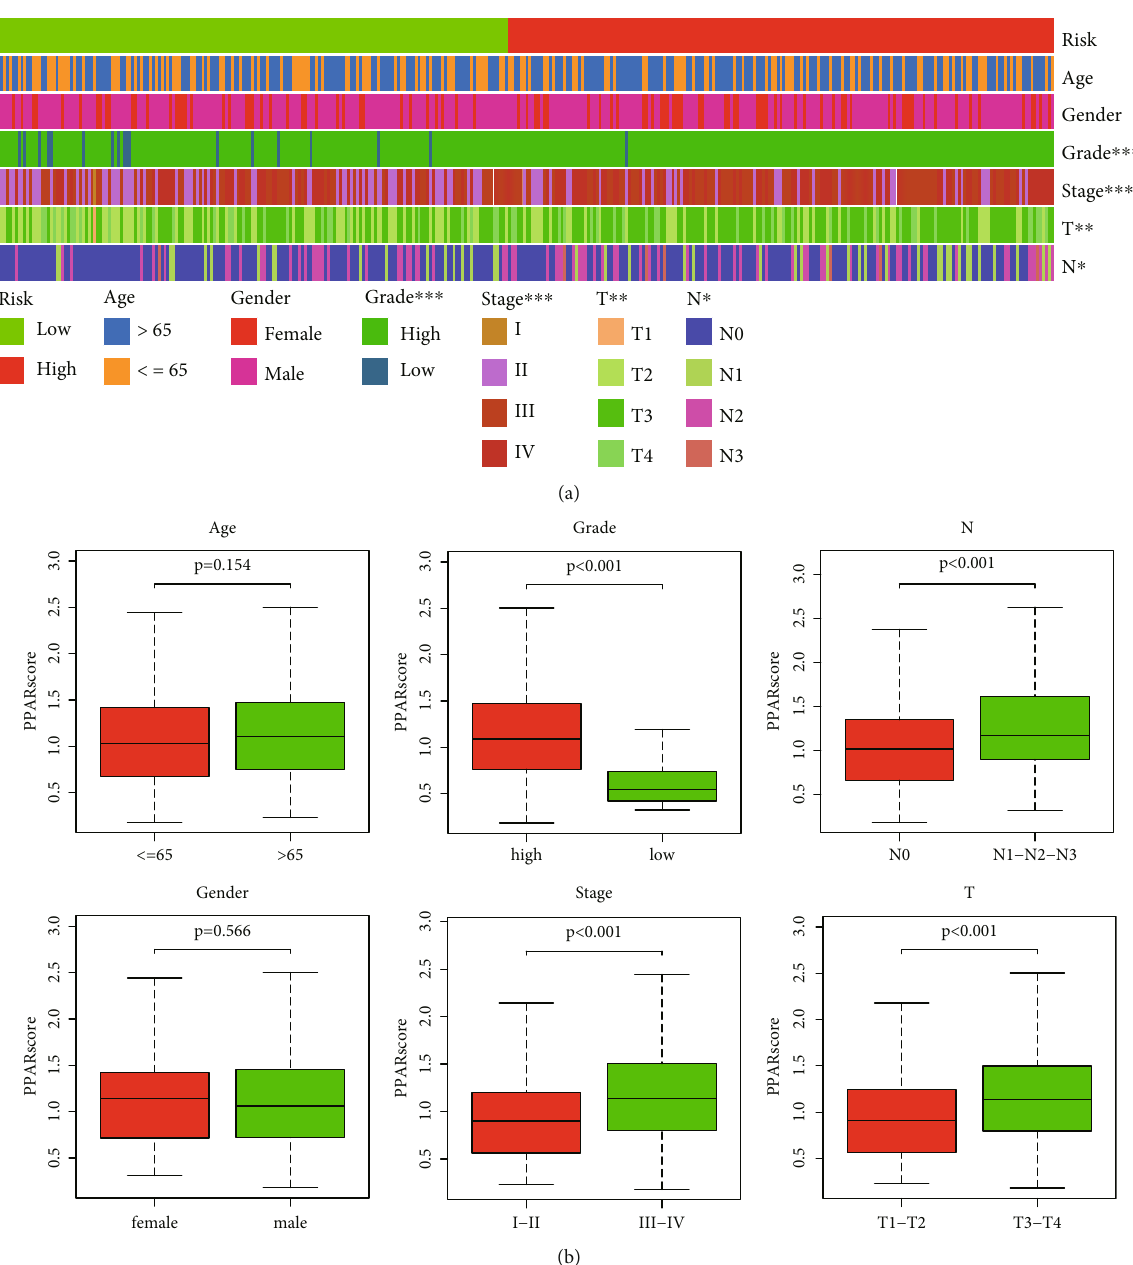
Figure 8: The correlation between the risk scores and clinicopathological factors. (a) Heatmap showed the relative expression of the risk score in BLCA patients at various clinical features, including age, gender, tumor grade, TNM stage, T stage, and N stage. ∗∗∗ P < 0 : 001 < ∗∗ P < 0 : 01< ∗ P < 0 : 05 ; (b) boxplot showed the relative expression of the risk score in BLCA patients at subgroups strati fi ed by age, gender, tumor grade, TNM stage, T stage, and N